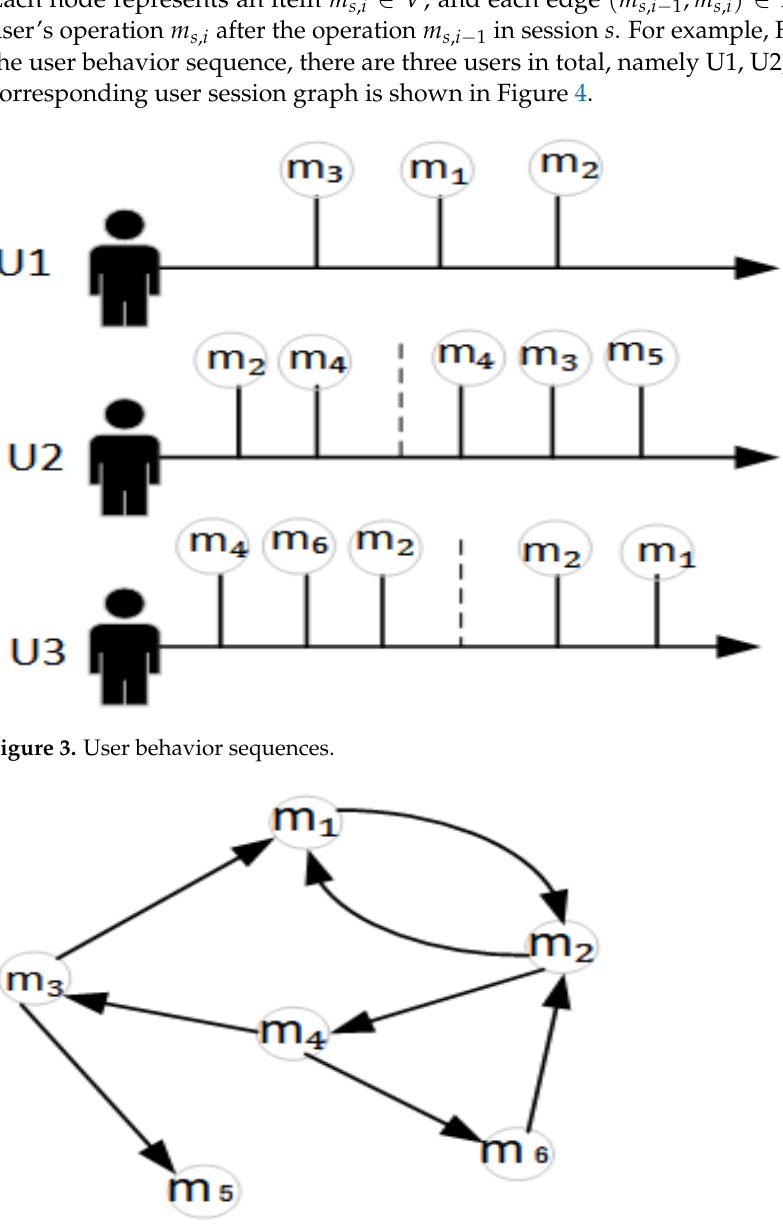
Figure 4. User session